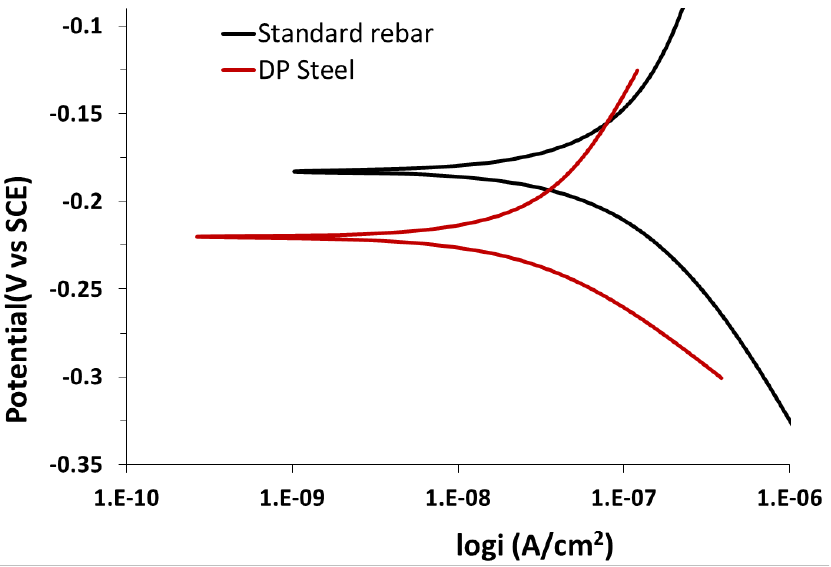
Figure 12. Potentiodynamic polarization results for standard rebar and DP steel in 0.015 M NaHCO 3 + 0.005 M Na 2 CO 3 (pH = 9.0) solution.